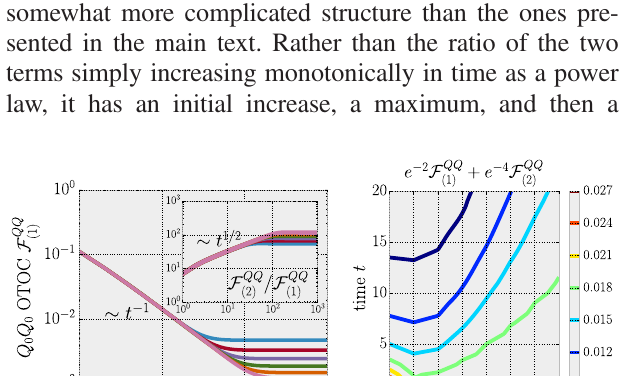
15. Left: First nonvanishing contribution to the OTOC at order e − μ for system sizes L ¼ 20 ; 24 ; … ; 40 . This term decreases as 1 =t until saturation. Inset: Ratio of the second- and first-order contributions increases as value. Right: Contour lines of the at O ð e − 2 μ Þ for μ ¼ 2 , consistent with diffusively spreading OTOC front.